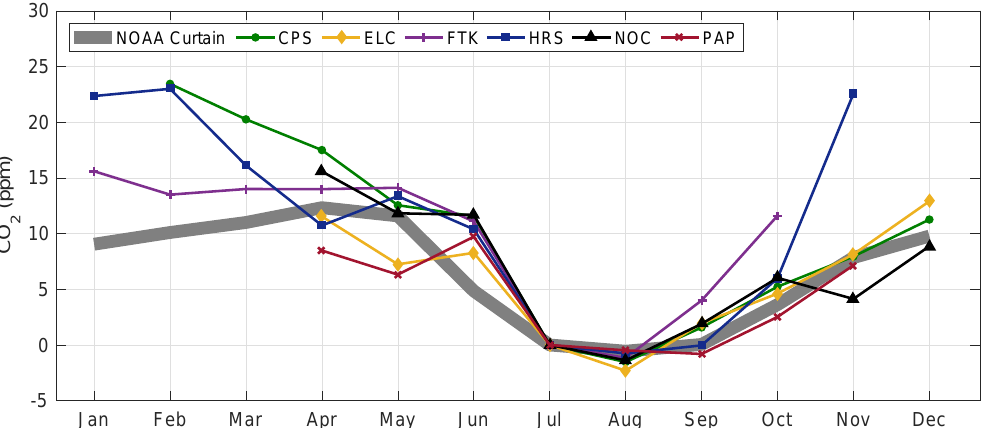
Figure 10. Monthly minimum drift- and bias-corrected CO 2 dry air mole fractions observed during 2013 at the same six BEACO 2 N sites shown in the bottom panels of Fig. 9, plotted as the enhancement above the July value. Bold gray curve shows a similar treatment of the surface level Pacific Ocean empirical boundary curtain values for 38 ◦